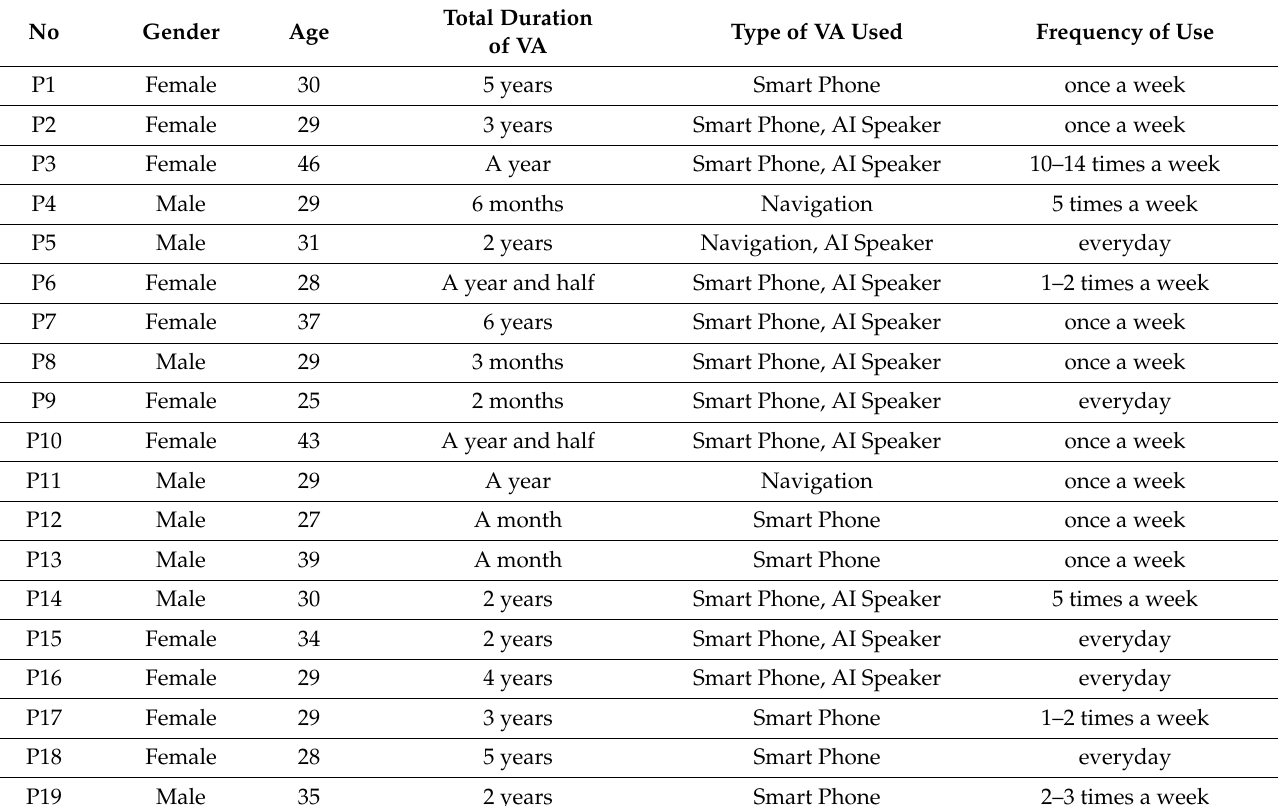
Table 1. Participants Information